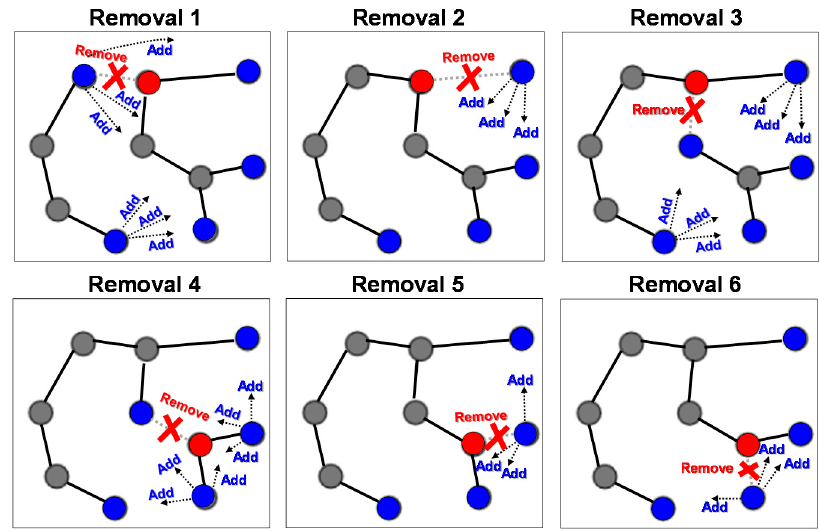
Figure 10. All possible removal-addition pairs. Figure 9. All possible removal-addition pairs. Appl. Sci. 2021 , 11 , x FOR PEER REVIEW